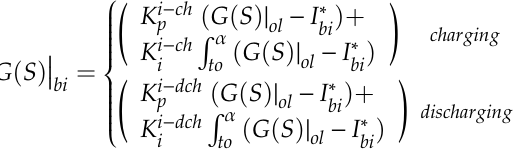
Figure 11. Shows the impact of different delays with C T = 4800 μ F and I m = 7.1 A on ( a ) load current, ( b ) boost converter output current, ( c ) bidirectional output current, and ( d ) DC bus voltage.